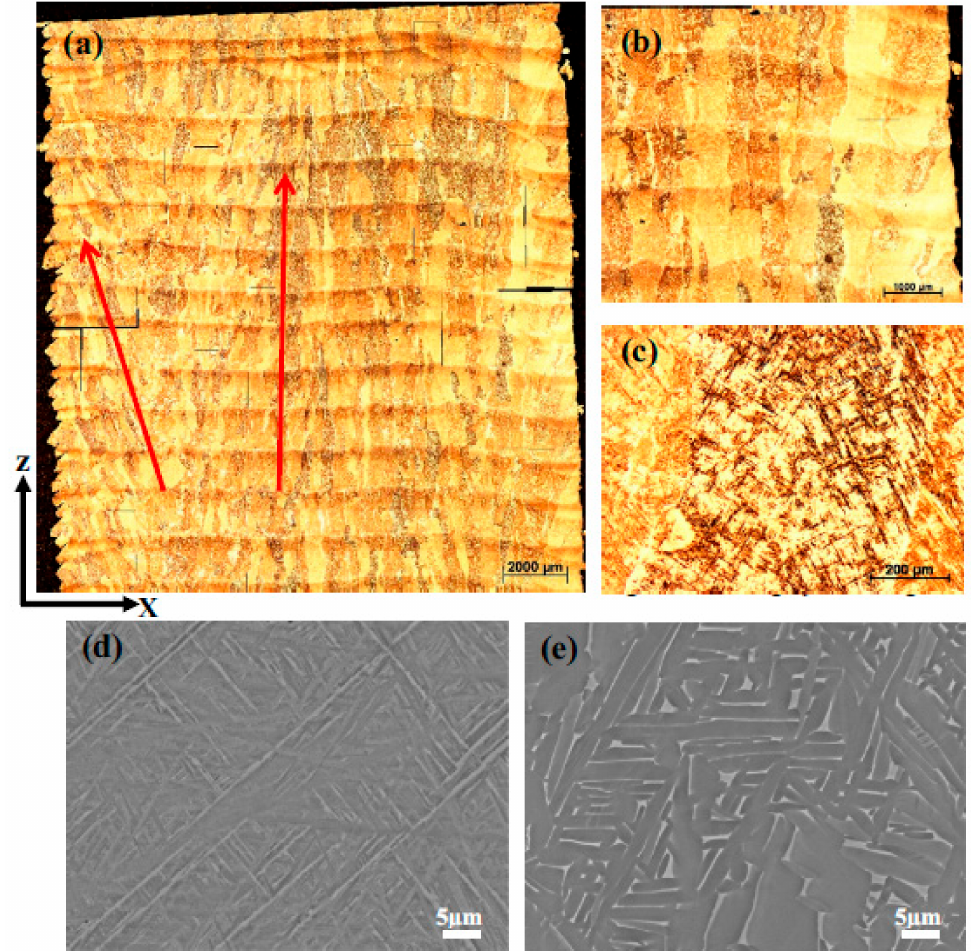
Figure 9. ( a – c ) OM X–Z sectional micrographs showing grain structure in as-DED samples; ( d , e ) back scattered electron SEM micrographs showing microstructure of as-DED and DED + HIPed samples, respectively. The arrows show the grain growth directions in different regions of the samples (reproduced with permission from [88] Copyright Elsevier,